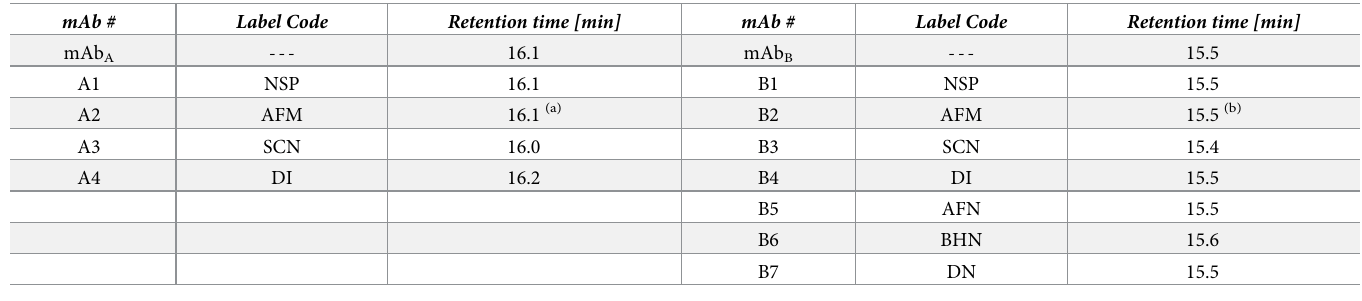
Table 3. Retention times in size-exclusion chromatography. mAb # Label Code Retention time [min] mAb # Label Code